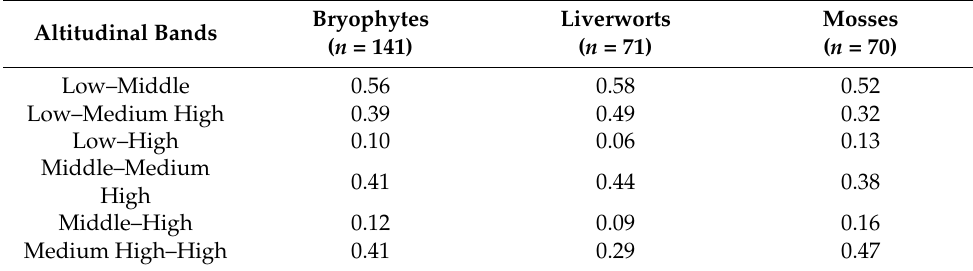
Table 4. Sørensen’s similarity indices (SSIs) between pairs of elevational zones in the Pico Island transect. (Elevational zones: low, 10–400 m a.s.l.; middle, 600–1000 m a.s.l.; medium-high, 1200–1600 m a.s.l.; and high, 1800–2200 m a.s.l.). Altitudinal Bands